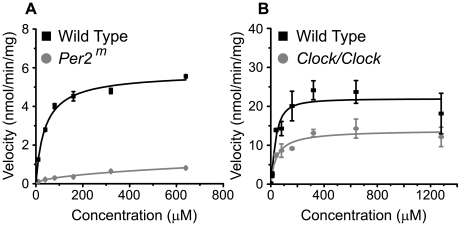
Glutamate uptake depends on the Clock and Per2 genes.Dose–response curves for glutamate uptake were generated comparing wild-type astrocyte cultures and either Clock/Clock or Per2m mutant astrocytes. A, Glutamate uptake was significantly reduced in astrocytes derived from Clock/Clock mutants compared to wild-type (+/+) glia (n = 3 cultures per concentration, mean±SEM). B, Glutamate uptake was significantly reduced in astrocytes derived from Per2m mutants compared to wild-type (+/+) glia (n = 3 per concentration, mean±SEM).